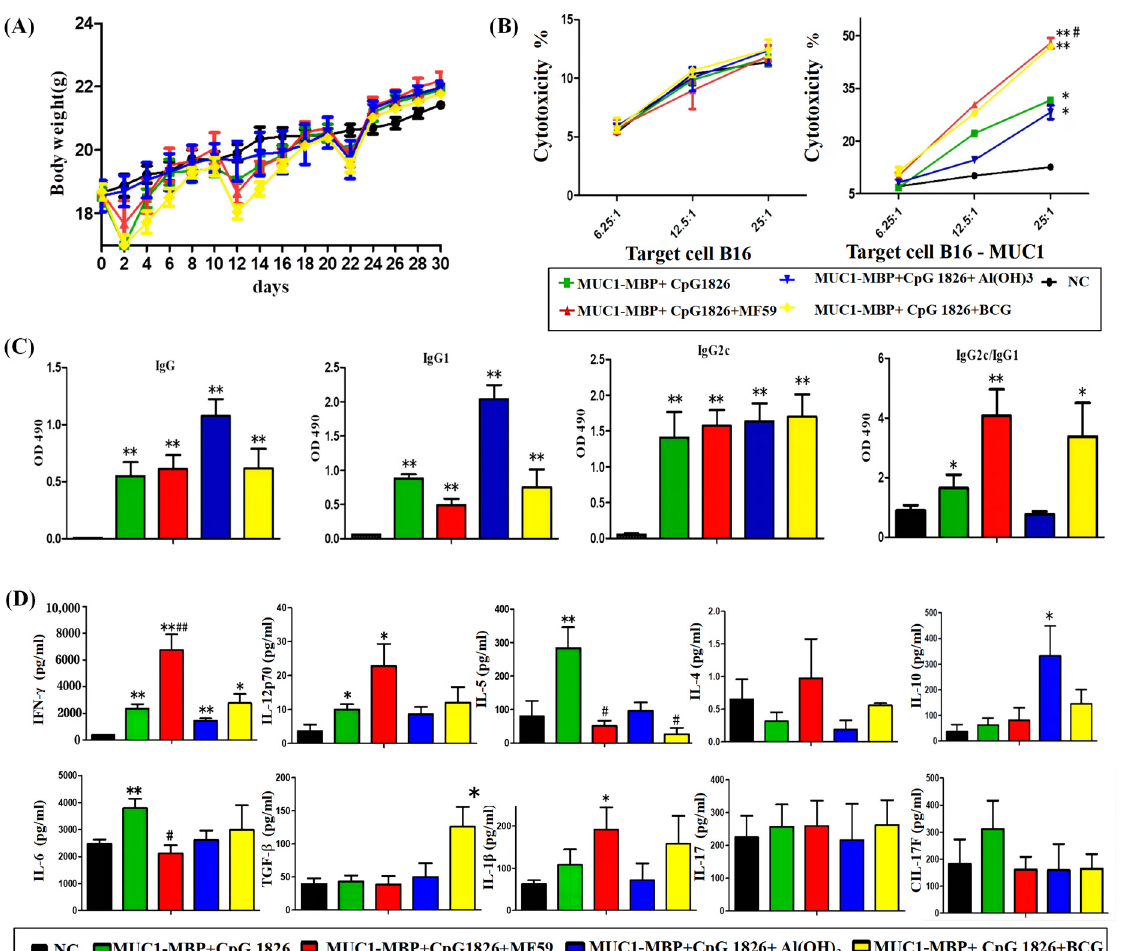
Figure 1. The effect of different adjuvant screenings in the combination of M-M/CpG 1826 on inducing MUC1-specific humoral and cellular immune responses. Mice were immunized with M-M/CpG 1826, M-M/CpG 1826/MF59, M-M/CpG 1826/Al(OH) 3 , M-M/CpG 1826/BCG or PBS once a week for a total of four times, in which the BCG-combination group was immunized twice ( n = 10/group). The mice were killed four days after the last immunization. The sera were collected for the MUC1-specific antibody assay. The splenic mononuclear cells from each group were stimulated in vitro with a specific MUC1 peptide (20 µg/mL) for five days, and then a cell proliferation assay and cytokine assay were carried out. ( A ) Effects of different formulations of M-M combined with CpG 1826 on the body weight of mice. ( B ) Effects of different formulations of M-M combined with CpG 1826 on antibody subtypes in mice. ( C ) CTL killing activity on target B16 neo or B16-MUC1 cells. ( D ) The original image of the chip analysis and its expression in a bar graph of splenocyte cytokine secretion by the Quantibody® array. Each mouse was replicated four times, and each group consisted of four mice. * p < 0.05, ** p < 0.01 vs. NC group. # p < 0.05, ## p < 0.01 vs. the M-M/CpG 1826 group.